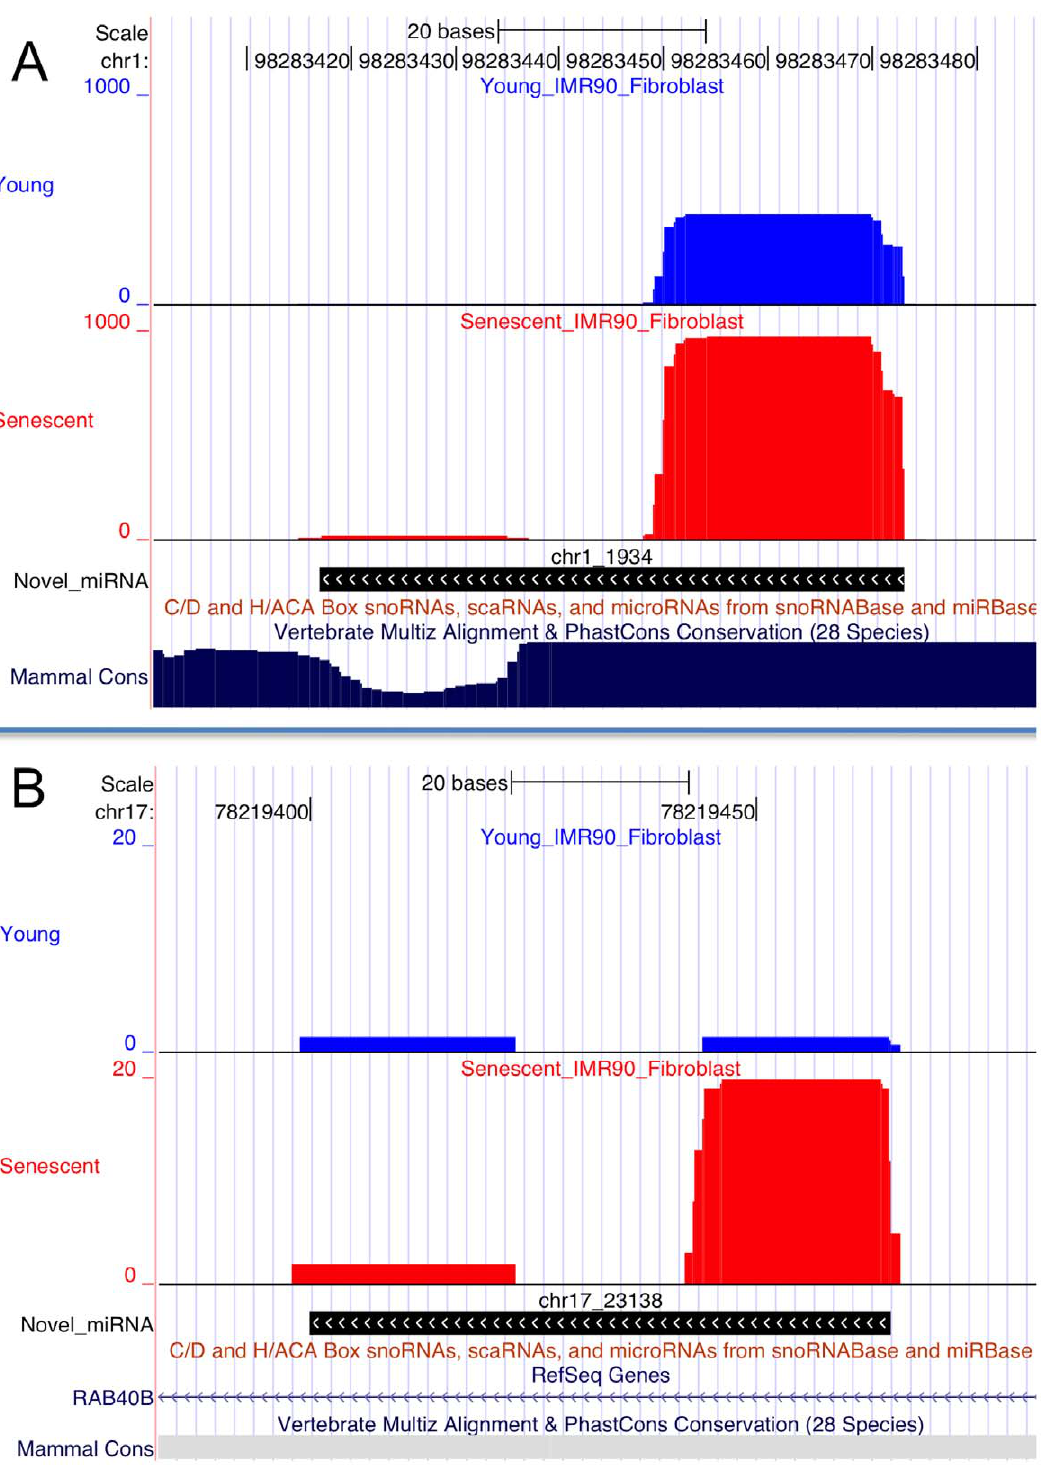
Figure 1. Examples of novel miRNAs discovered by deep sequencing of IMR90 fibroblasts. Expression of both novel miRNAs is increased by senescence. A) Novel miRNA located in a conserved genomic region. Shown are screenshots from the UCSC genome browser, displaying the Illumina sequencing reads (blue: young IMR90; red: senescent IMR 90), and the novel precursor miRNA (black) predicted by miRDeep2 with provisional id chr1_1934 (see Table 1). The mammalian conservation track is at the bottom (deep blue). UCSC genome browser tracks for non-coding RNAs are shown, with no RNAs annotated in this region. The ‘‘stacks’’ of sequence reads identify the mature miRNA, which is more abundant in the senescent IMR90 cells. The coverage depth (number of reads, y-axis) shows few reads mapping to the star region of the miRNA precursor. B) Novel miRNA with provisional id chr17_23138 (see Table 1) predicted to map to an intron by miRDeep2. The same UCSC genome browser tracks as in A are shown. The precursor miRNA is in black. Note the scale on the y-axis: this novel miRNA is less abundant than the example in A.